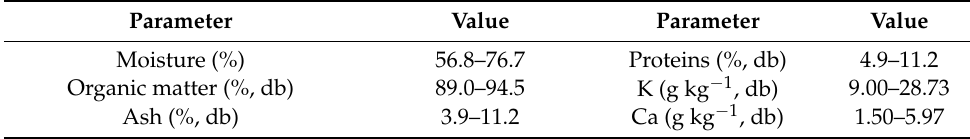
Table 3. General composition of grape